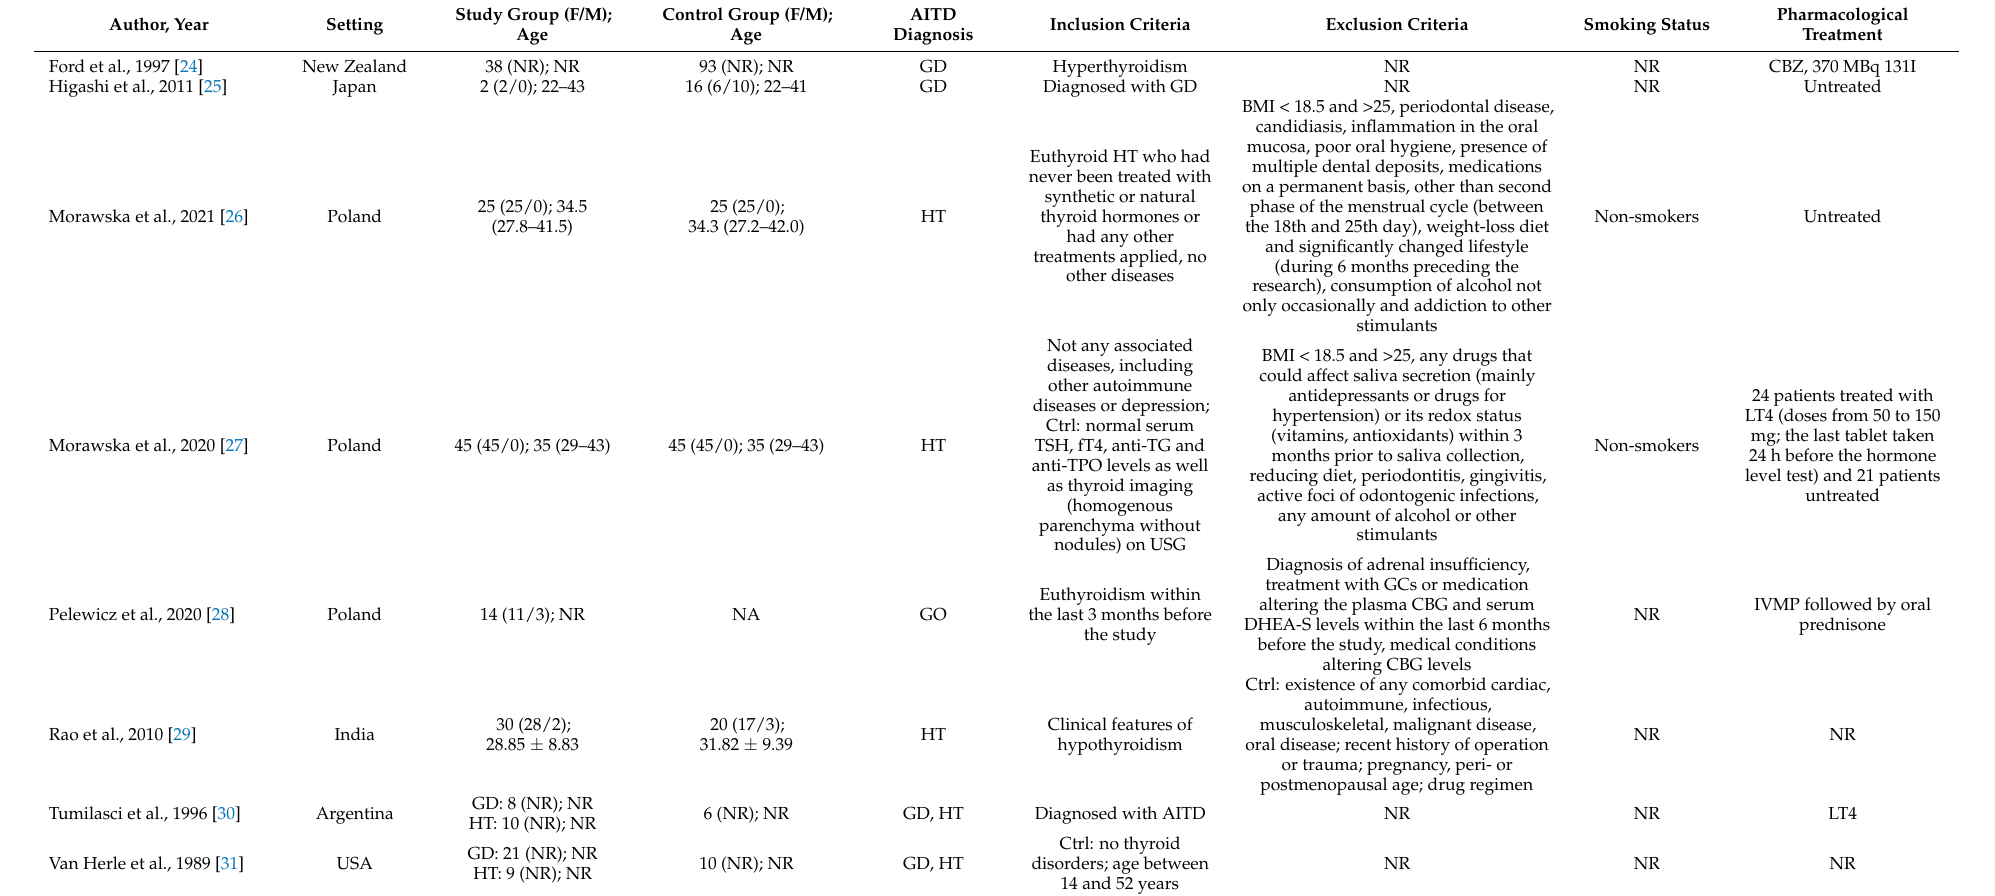
Table 2. General characteristics of included studies considering mainly qualitative assessments of